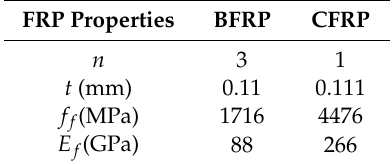
Table 3. Mechanical properties of the two types of Fiber-Reinforced Polymer (FRP) jackets.